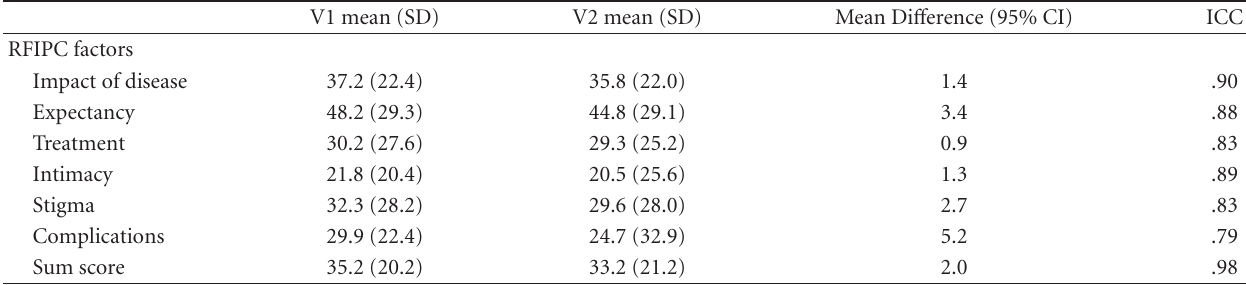
Table 5: Test-retest reliability with intraclass correlation coe ffi cients (ICC) in patients reporting no change in their condition from baseline to followup after 6 months.